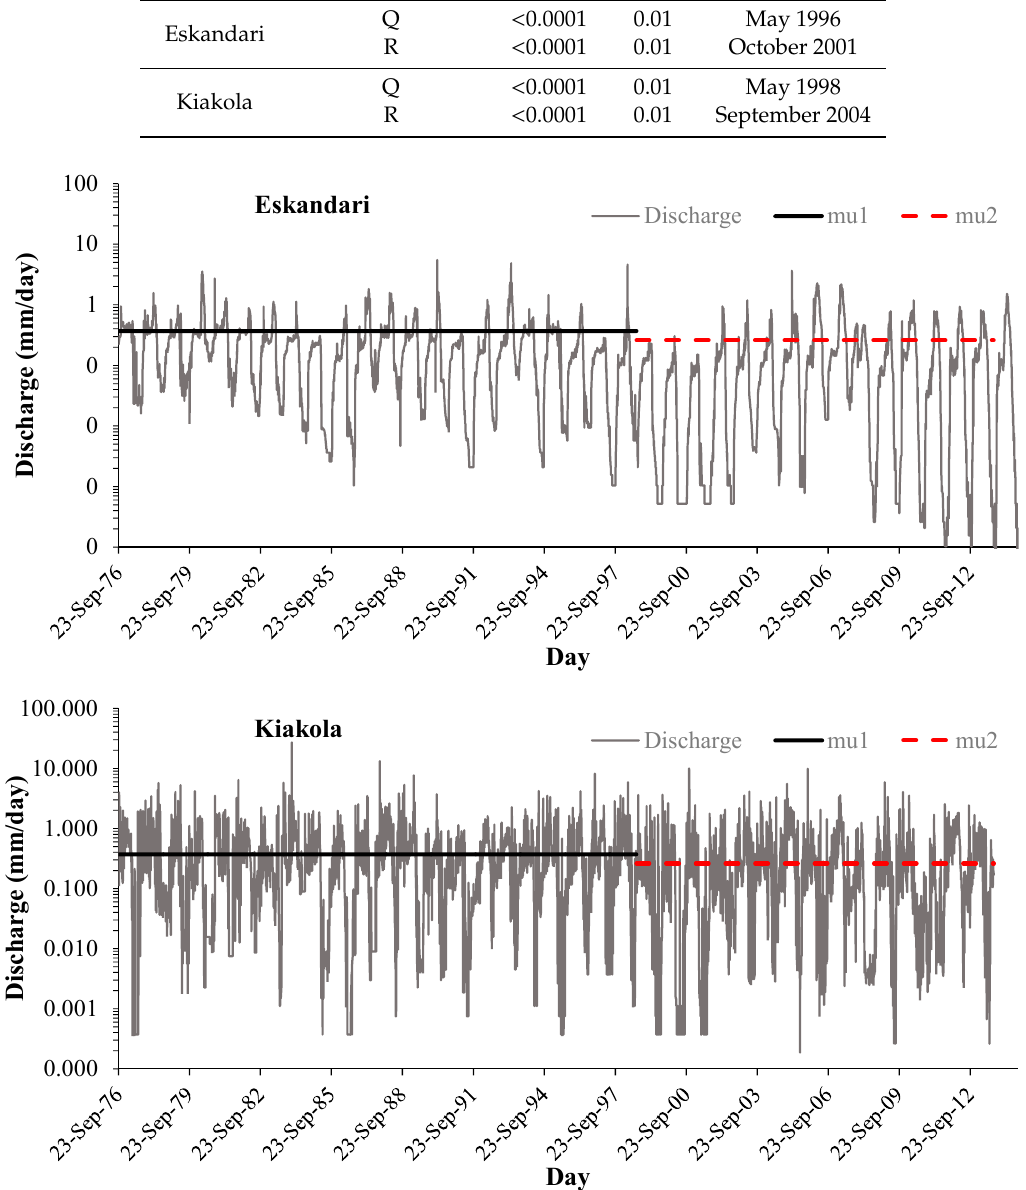
Figure 4. Pettit’s test for discharge.